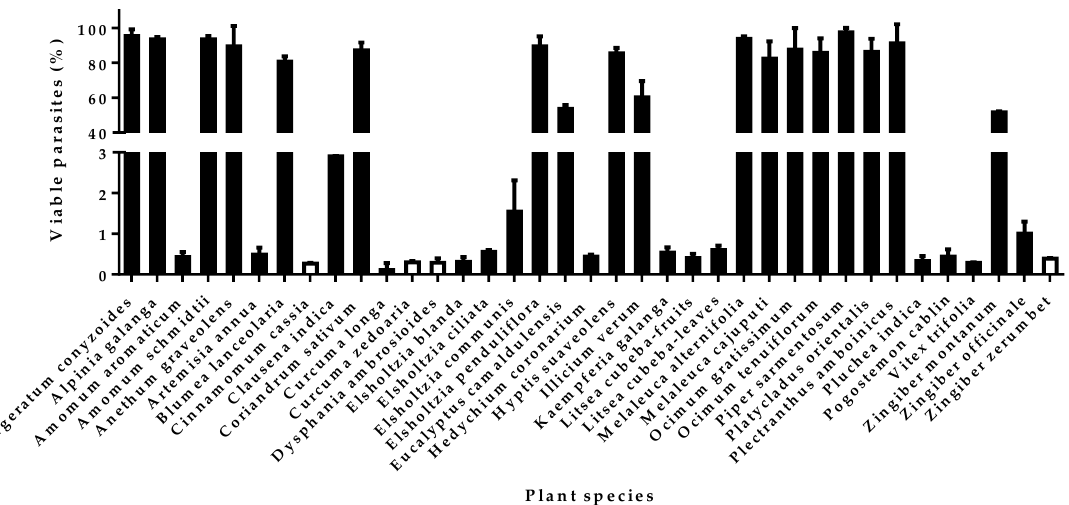
Figure 1. Viability percentages of Tbb bloodstream form treated with 25 nL/mL (in black) or 10 nL/mL (in white) of EO. Mean ± SD calculated in triplicate repeated twice and normalized according to negative control. The IC 50 of the positive control (suramin) in those experiments was 21.53 ± 2.62 ng/mL. Table 1. Anti-trypanosomal activity, cytotoxicity, and selectivity indices of the 19 selected EOs. Plant Species (Studied